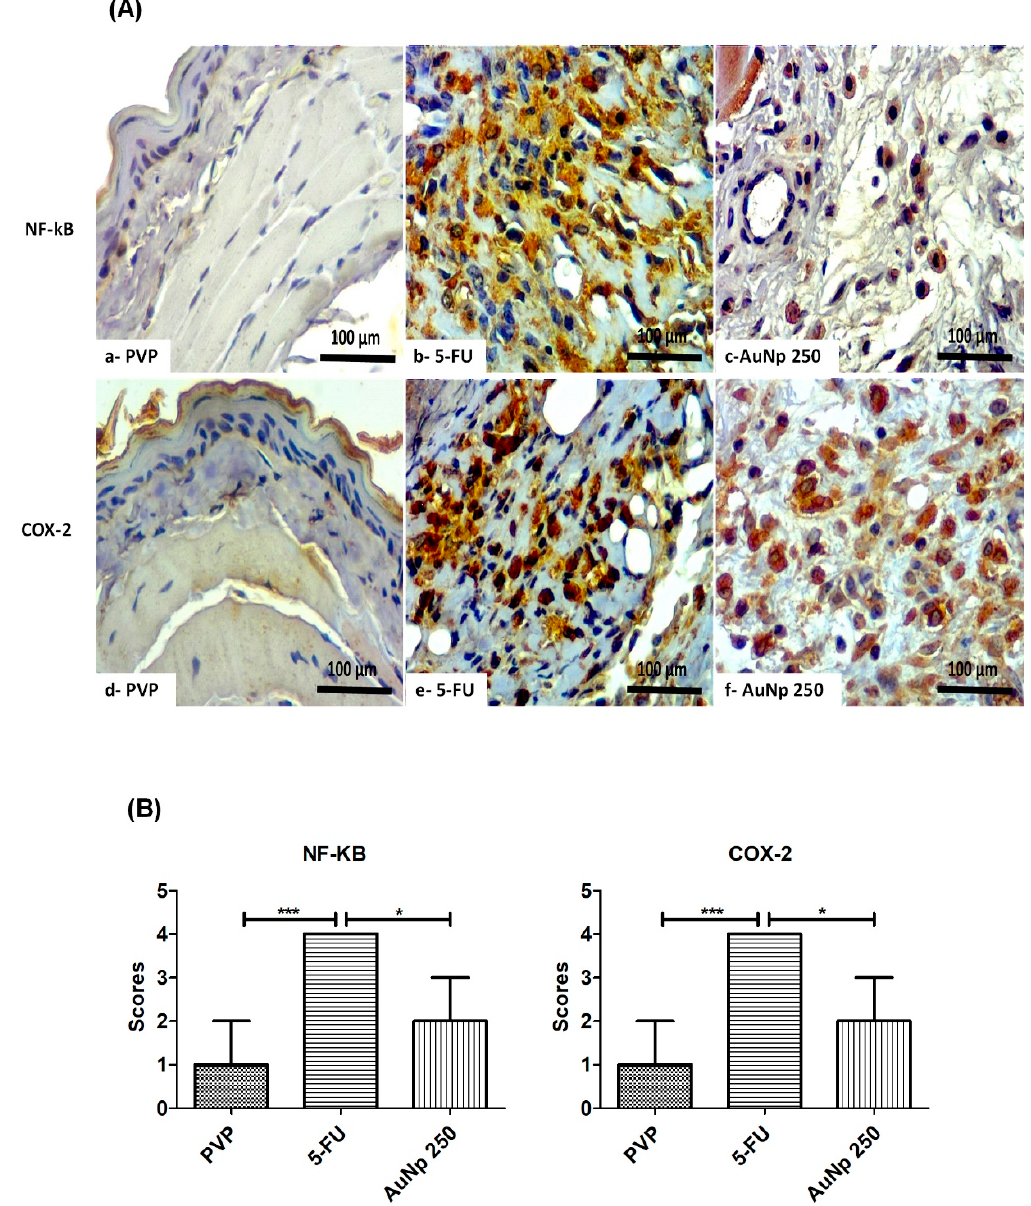
Figure 5. ( A ) Immunohistochemistry and ( B ) scores for NF- κ B or COX-2. The PVP group with reduced immunostaining. The inflammatory cells of the oral mucosa in the 5-FU group had intense labeling for NF- κ B or COX-2 compared to the PVP animals. In contrast, AuNp at 250 μ g/kg reduced the immunostaining for NF- κ B or COX-2, compared to the 5-FU group. ( n = 5/group). * p < 0.05; ** p < 0.001 (Kruskal–Wallis test and Dunn’s multiple comparison test).